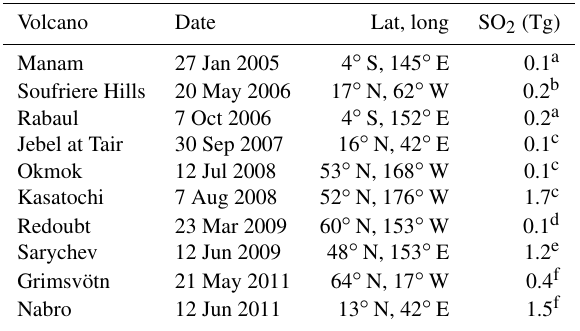
Table 1. Most significant volcanic eruptions for the aerosol concen- tration in the Northern Hemisphere LMS in the time period